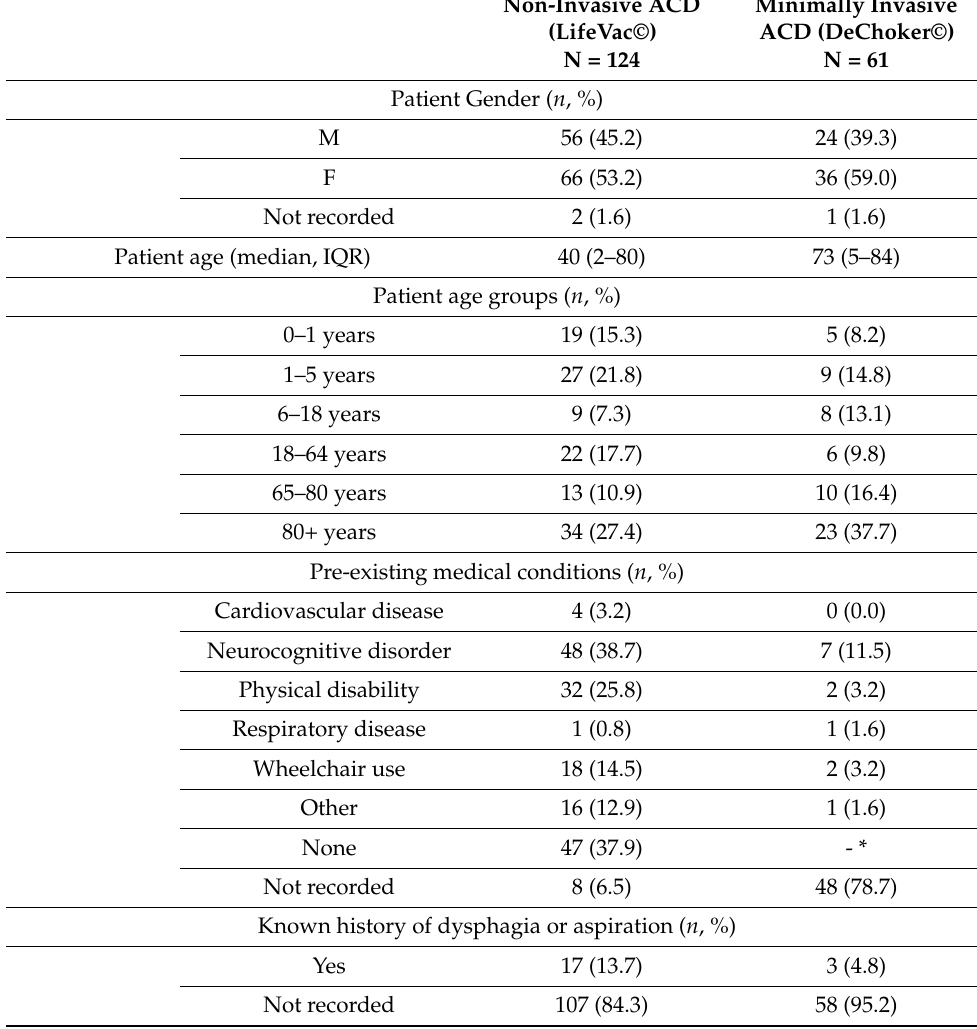
Table 1. Characteristics of patients with a foreign body airway obstruction intervened by an airway clearance